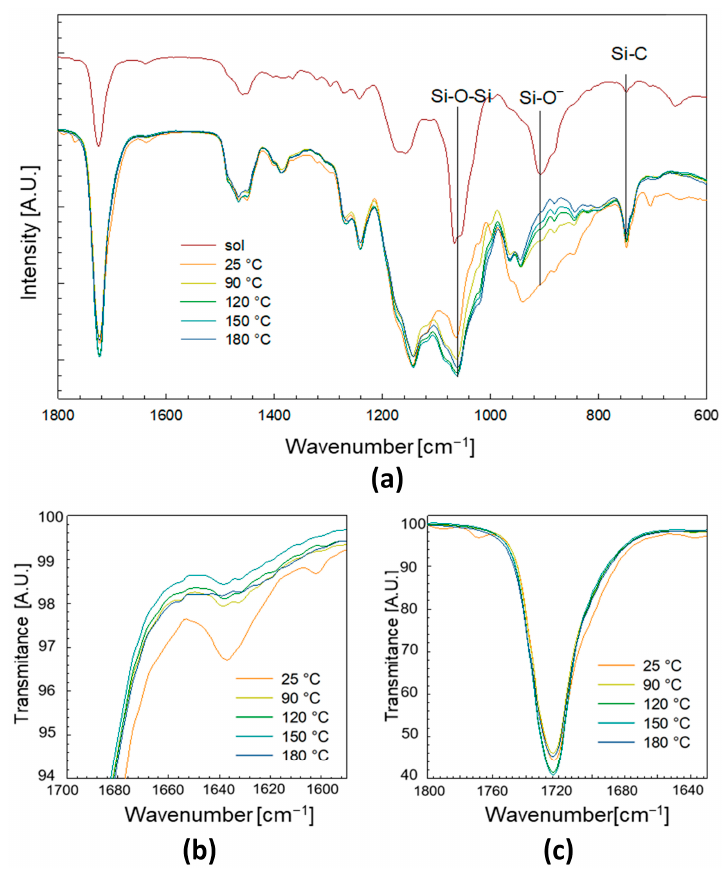
Figure 2. ( a ) ATR FTIR transmi tt ance (each bar represents 4%) spectra of as-prepared sol and coat- ings deposited on the metal substrate and cured at di ff erent temperatures (25 °C, 90 °C, 120 °C, 150 °C, 180 °C). The withdrawal rate was 2.3 mm/s. ( b , c ) show the insert of the speci fi c region of the C=C band at 1636 cm  1 and C=O band at 1724 cm  1 in FTIR